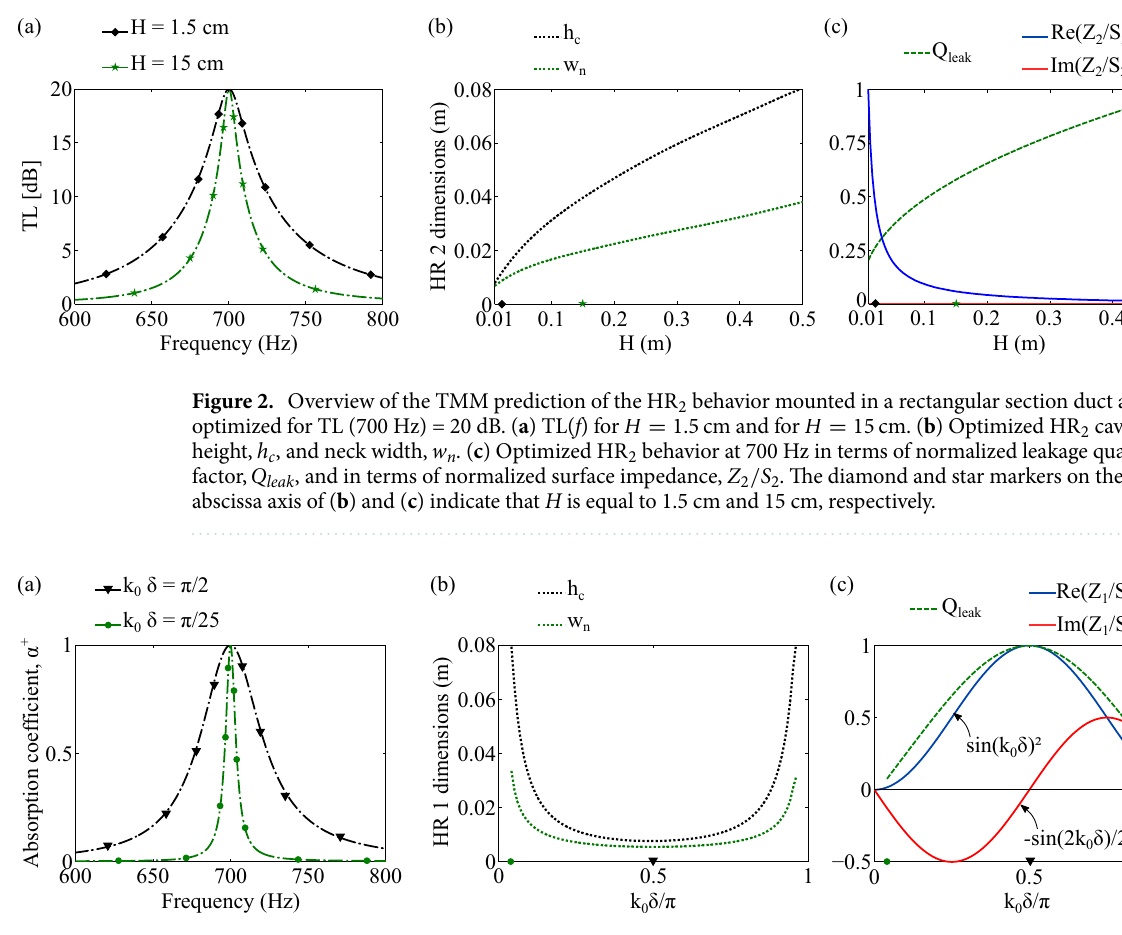
Figure 3. Overview of the TMM prediction of a FMAA behavior mounted in a rectangular section duct of 15 cm and such that HR 1 is optimized for α + ( 700 Hz ) height H = a perfect soft wall at a distance δ . ( a ) α + ( f ) of optimized FMAA for k 0 ( 700Hz )δ π/ 25 . ( b ) Optimized HR 1 cavity height, h c , and neck width, w n . ( c ) Optimized HR 1 behavior in terms = of normalized leakage quality factor, Q leak , and in terms of normalized surface impedance, Z 1 / S 1 . The dot and triangle maker on the abscissa axis of ( b ) and ( c ) indicate that k 0 ( 700 Hz )δ is equal to π/ 25 and π/ 2 ,